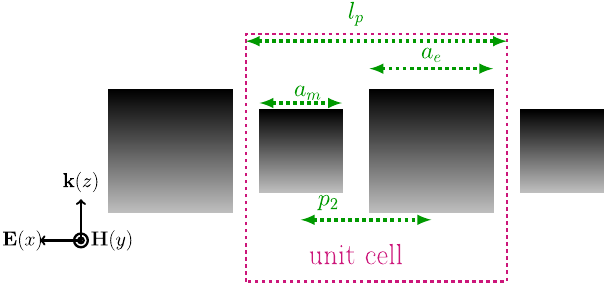
Fig. 1. Schematic layout of the 2D ADM (cross-sectional view). The ADM consists of one in fi nite layer along the x direction and is made up of two interleaved sets of high permittivity square cross- section dielectric cylinders, which resonate in the fi rst two modes of Mie resonances: the small set resonates in the magnetic mode and the second one in the electric mode. The equidistant cylinders are in fi nite along the y direction and their side lengths are a m =60 m m and a e =90 m m, respectively. Their relative permit- tivity is (cid:1) r =94. The unit cell actually consists of two subwavelength distinct building blocks. The lattice period is l p = 260 m m and p 2 is half the lattice period. The incident wave is transverse electric